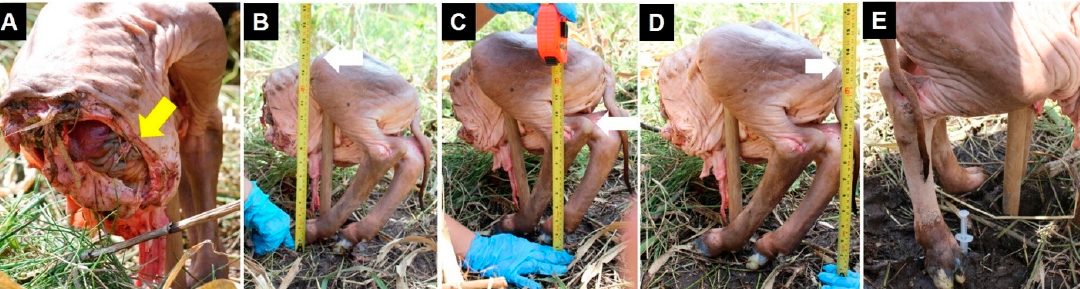
Figure 2. ( A ) The yellow arrow shows some visceral, organs and tissues still present in the abdominal cavity; ( B ) The distance between the explosive and the coxal tuberosity (high: 36–37 cm) (white arrow); ( C ) The distance between the explosive and the calcaneal tuberosity (high: 23–25 cm) (white arrow); ( D ) The distance between the explosive and the ischial tuberosity (high: 32–33 cm) (white arrow); ( E ) The homemade AP landmine positioned by the inner side of the animal’s right foot.